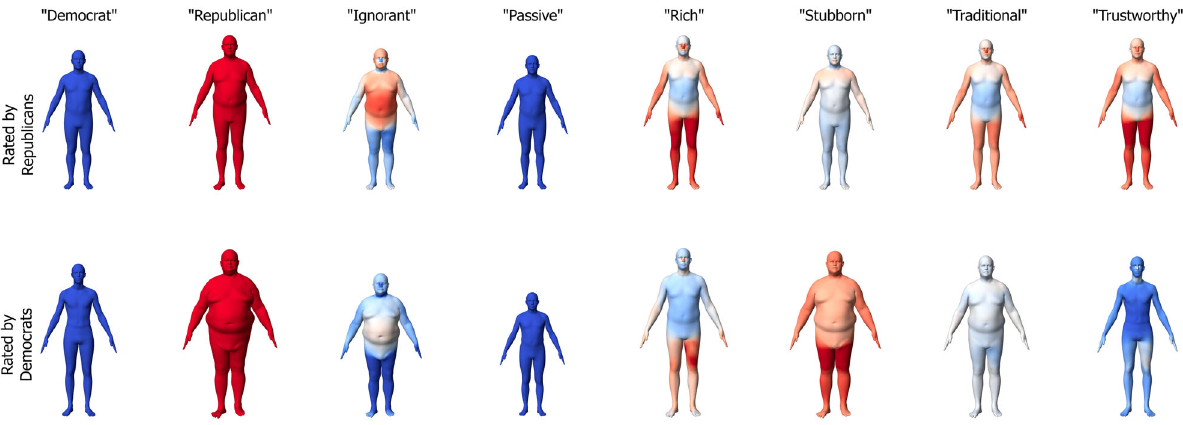
Fig. 6 Stereotype bodies as seen by Republican and Democrat groups. Blue color indicates a geometric closeness to the Democrat stereotype, while red color represents geometric closeness to the Republican stereotype, per